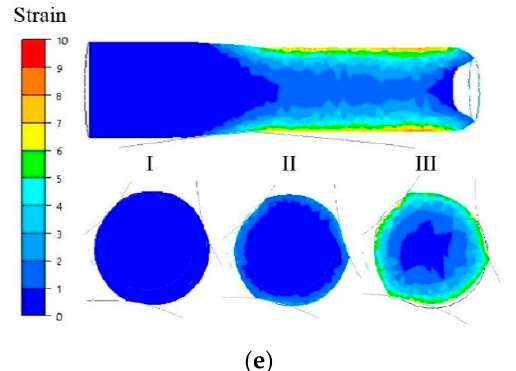
Figure 8. Distributions of cumulated plastic strain on the longitudinal sections and cross-sections of deformed bars at a temperature of, respectively ( a ) 150 ◦ C; ( b ) 200 ◦ C; ( c ) 250 ◦ C; ( d ) 300 ◦ C; and ( e ) 350 ◦ C.